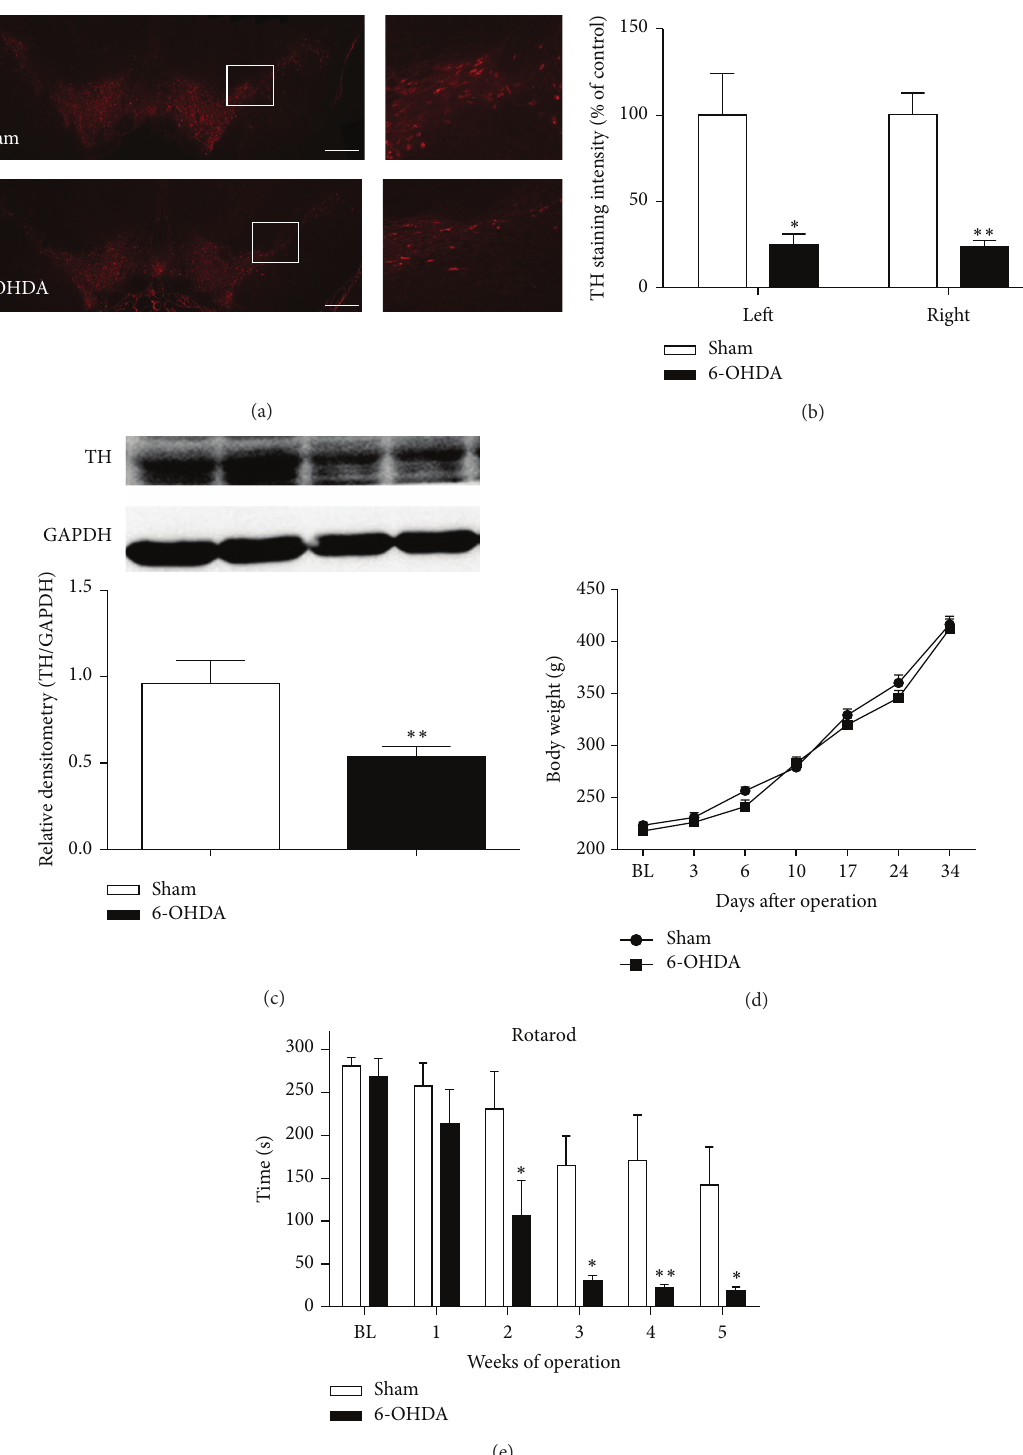
Figure 1: Parkinson’s disease model induced by stereotaxic infusion of 6-OHDA into the bilateral striatum of rats. (a) Representative photomicrographsofcoronalsectionshowingtyrosinehydroxylase-immunoreactiveneuronsandfibersinthesubstantianigra(SN).Theright lanes of pictures are higher magnification of boxed area. Scale bar = 100 𝜇 m. (b) The quantification analysis showed the TH-immunostaining intensity in SNc plus SNr (substantia nigra reticular part) at the 5th week after microinjection. Compared with the sham group, the TH- immunoreactivity was significantly decreased in the 6-OHDA-treated group ( ∗ 𝑃 < 0.05 , ∗∗ 𝑃 < 0.01 compared to the sham control, 𝑛 = 4 for each group). (c) The expression level of TH in striatum (CPu) was revealed by western blotting. TH expression in striatum (CPu) was significantly reduced in 6-OHDA-treated rats at the 5th week after operation compared to the sham control. Bottom bar graph showed the relative density of TH/GAPDH between 6-OHDA-treated group ( 𝑛 = 4 ) and sham group ( 𝑛 = 4 ). ∗∗ 𝑃 < 0.01 compared to the sham control. (d) There was no significant difference for body weight between 6-OHDA-treated group ( 𝑛 = 10 ) and sham group ( 𝑛 = 10 ). (e) The rotarod test showed that comparing to the sham group ( 𝑛 = 5 ), the latency time to fall from the rod for 6-OHDA-treated rats ( 𝑛 = 8 ) was significantly decreased from the 2nd week after operation ( ∗ 𝑃 < 0.05 ; ∗∗ 𝑃 < 0.01 compared to the sham